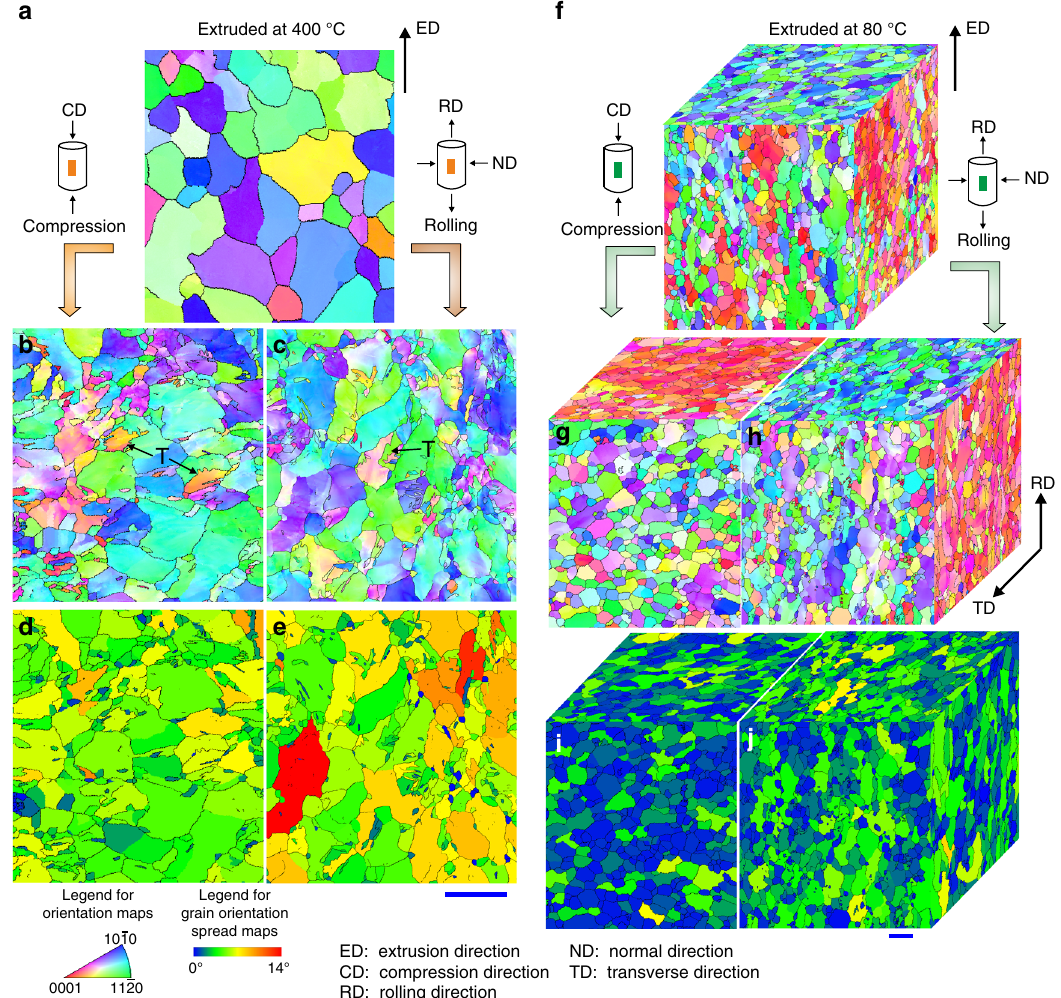
Fig. 3 Microstructures before and after deformation. a – e Electron backscattered diffraction and f – j transmission Kikuchi diffraction maps showing microstructure of specimens extruded at a – e 400 °C and f – j 80 °C and in a , f as-extruded state, b after 20% and g 50% compression, and c after 20% and h 50% cold rolling. d , e , i , j Maps showing orientation spread in individual grains in compressed and cold-rolled specimens. Scale bars in a – e and f – j indicate 100 µ m and 2 µ m,